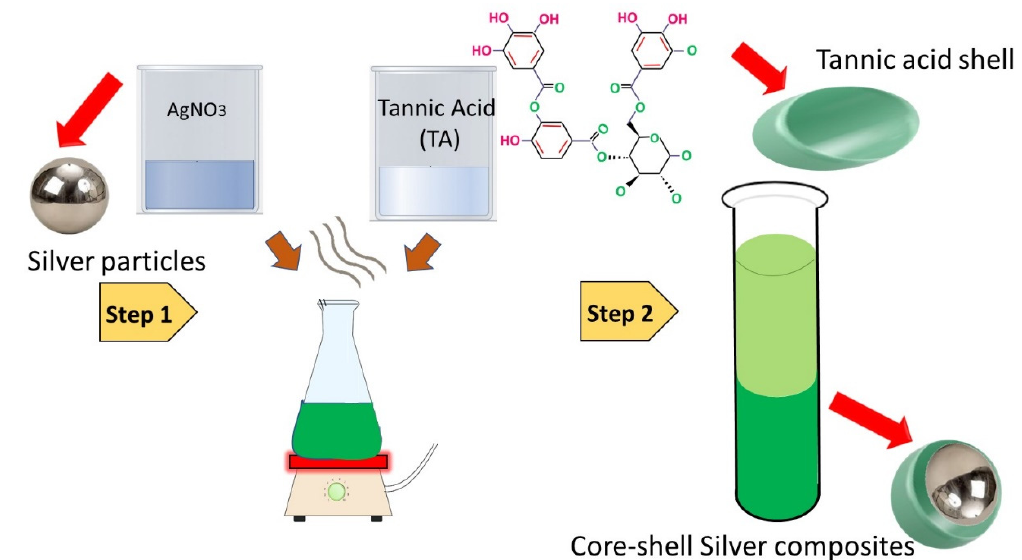
Figure 1. Schematic for the green synthesis of silver nanoparticles.